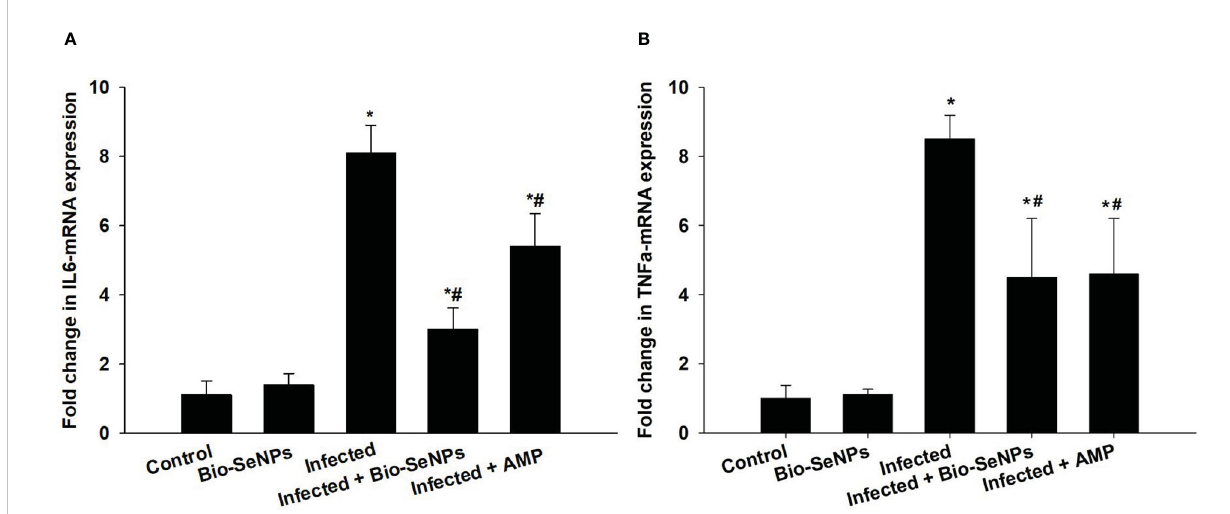
FIGURE 11 Effect of Bio-SeNPs on the mRNA expression of IL-6 (A) and TNF- a (B) in the jejunal samples from E. papillata -infected mice. The expression values obtained by RT-PCR analysis were normalized to the reference gene GAPDH mRNA level and are shown as fold induction (in log 2 scale) relative to the mRNA level in the control. * signi fi cance changes concerning the control group, # signi fi cance changes concerning the infected